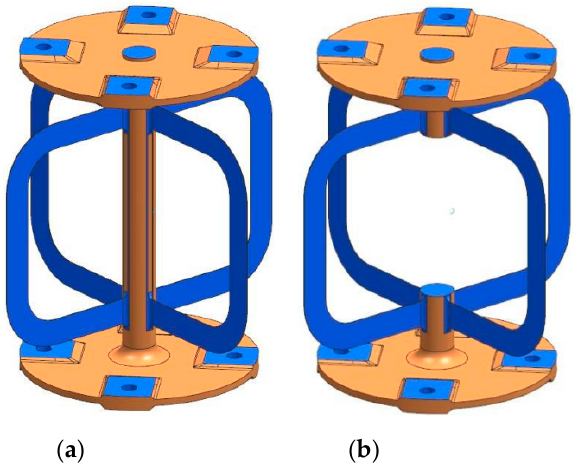
Figure 24. ( a ) Semifinished hinge with center rod; ( b ) final hinge with detached rod.